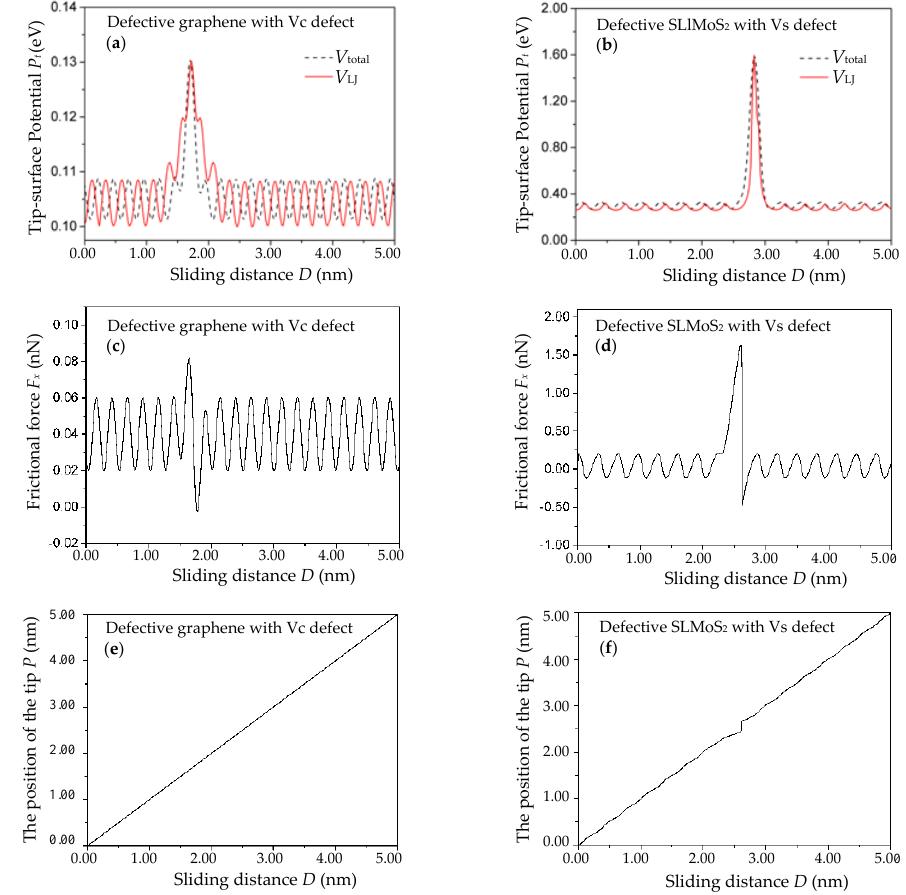
Figure 2. The tip-surface potential Pt vs. scanning distance D curves ( a , b ), the frictional force F x vs. the sliding distance D curves ( c , d ), and the position of the single-atom tip P vs. the sliding distance D curves ( e , f ) of the monovacancy-defective graphene and SLMoS 2 . The solid red curves and the dashed black curves in ( a , b ) were obtained by calculating the LJ potential ( V LJ ) and by fitting the LJ potential ( V LJ ) via the modified interaction potential ( V total ), respectively.